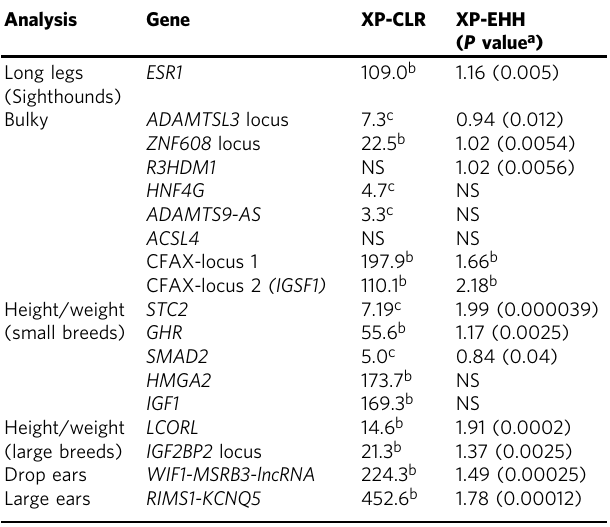
Table 5 Summary of XP-CLR and XP-EHH analyses between domestic dog breeds